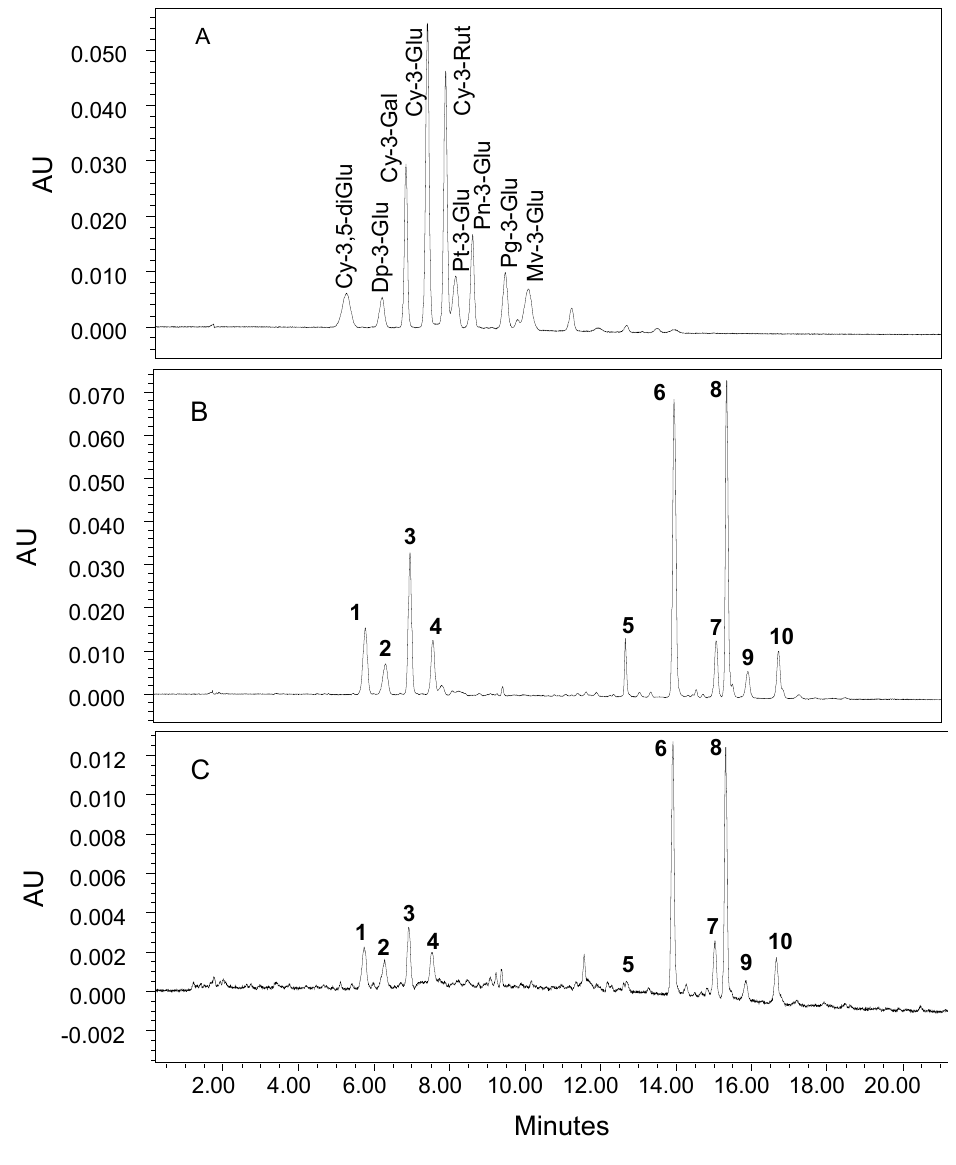
Figure 1. Typical UPLC chromatograms of a standard mix of 9 authentic anthocyanin compounds ( A ) and samples of purple tea leaves ( B ) and flakes ( C ). See Table 1 for identity of peak numbers.